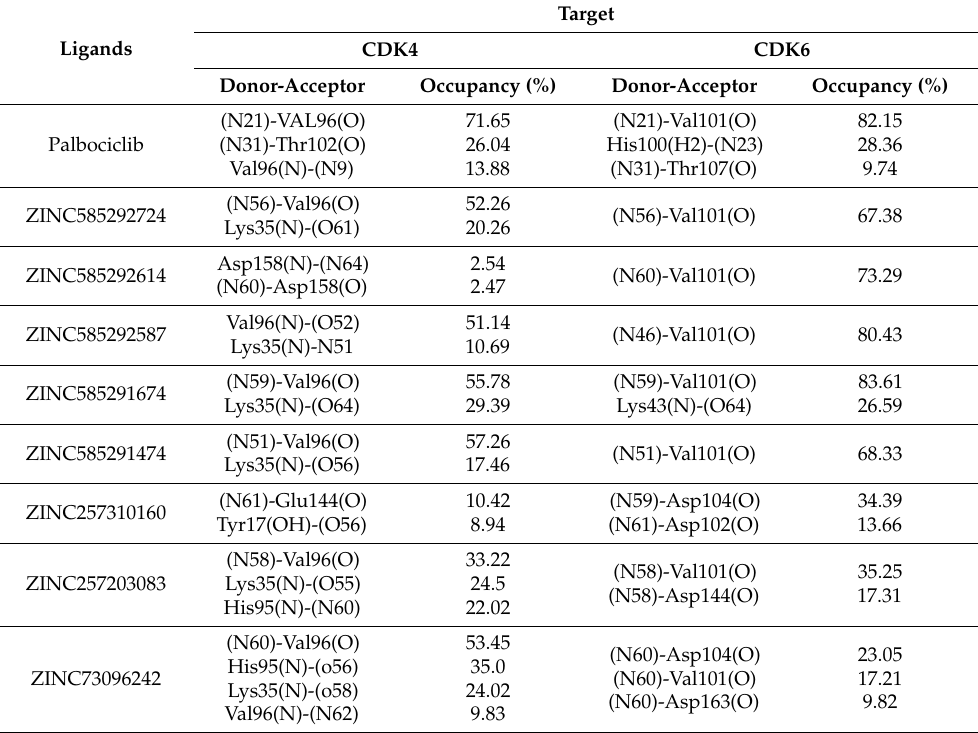
Table 4. The occupancy of hydrogen bond during 200 ns